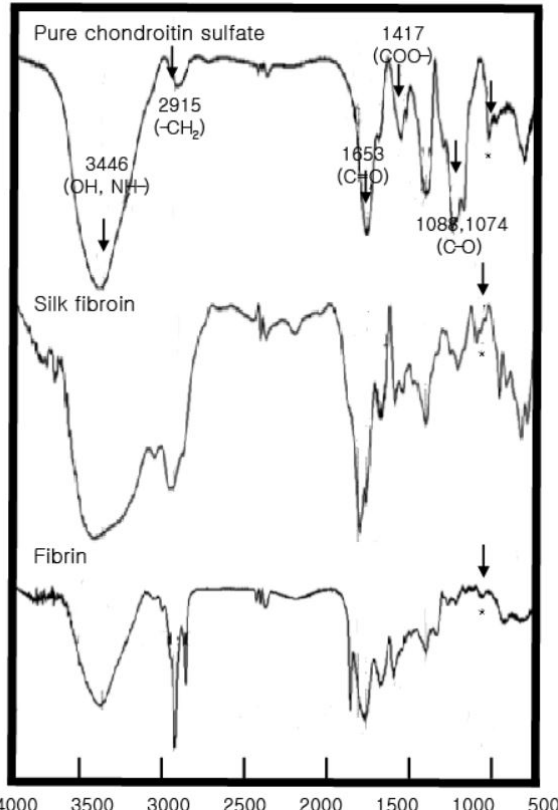
Figure 2. FTIR analysis of pure chondroitin 6-sulfate, silk fibroin, and fibrin. Peaks indicate specific chemical bonds. The peak near 850 cm −1 (*) represents the C-O-C structure of glucose, galactose, and chemical bonds. The peak near 850 cm − 1 (*) represents the C-O-C structure of glucose, galactose, and mannose, indicating the characteristics of monosaccharides. mannose, indicating the characteristics of